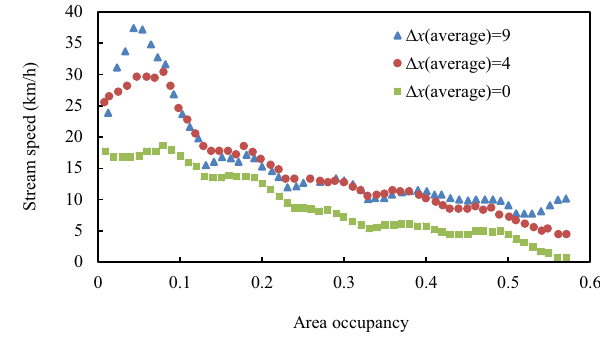
Fig. 13 Relationship between area occupancy and stream speed for different values of D x (average) and only car scenario using the PP- CA model